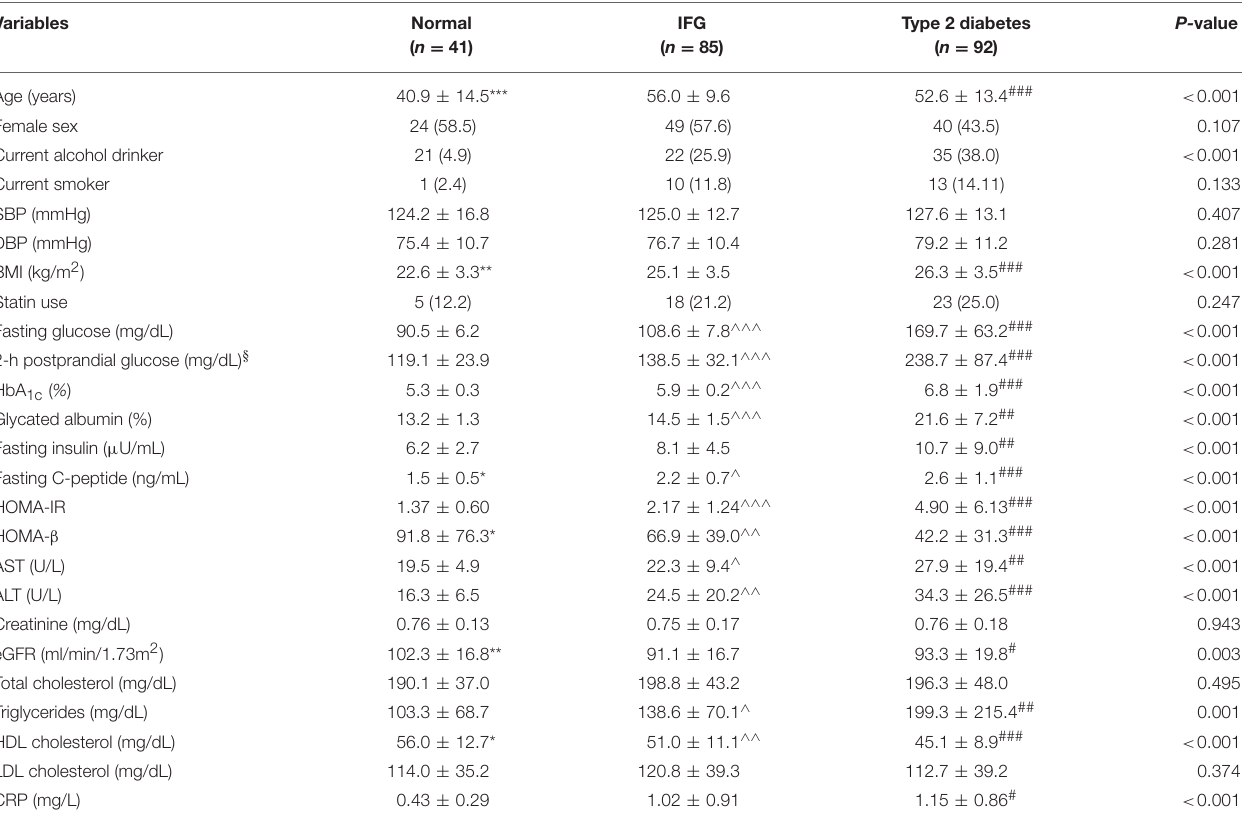
TABLE 1 | Characteristics of the study subjects ( n =